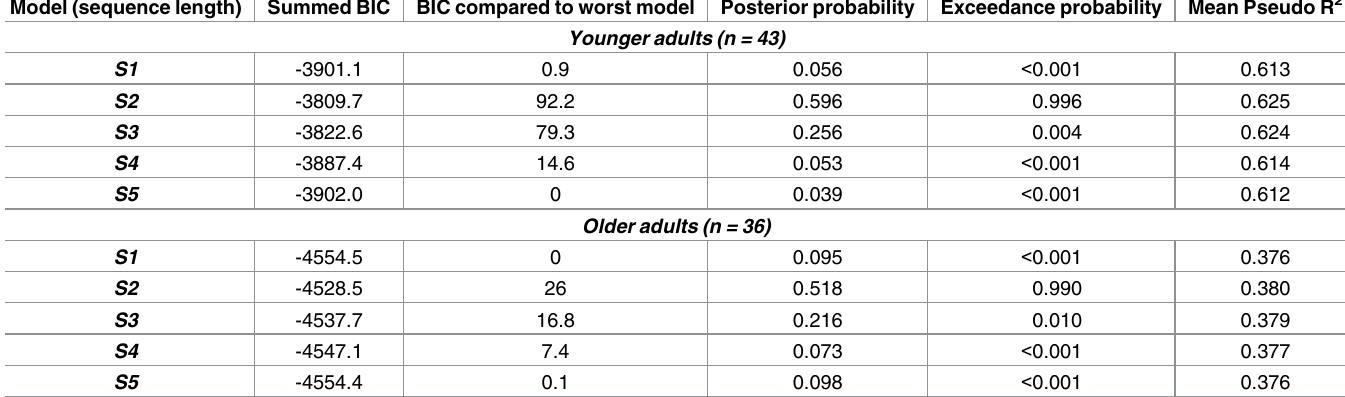
Table 1. Behavioural analysis of sequential inference strategies. In both youngerand older adults, randomeffects model comparison results strongly favour S2 , a model in which agents perform joint inferenceover the current and immediately precedingstates. Examination of the posterior probabilities, how- ever, suggeststhat a significantproportionof subjects in both groups performed inference over sequencesof length three or more (model comparison results are illustratedin Fig